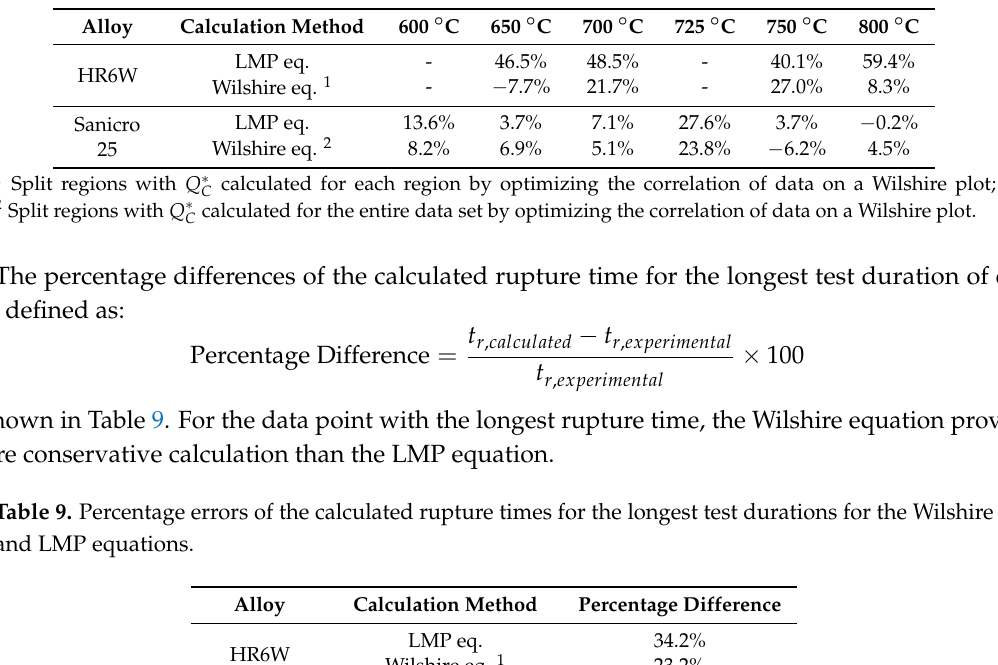
Table 8. Average percentage difference of calculated and experimental rupture times.